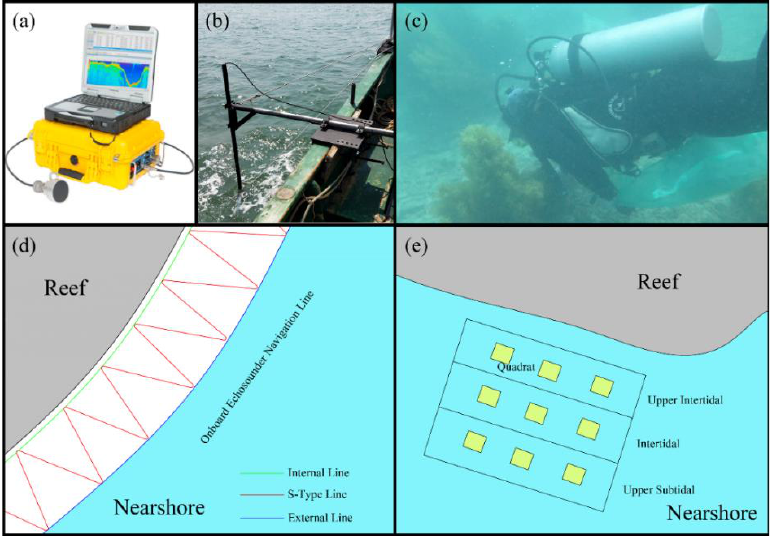
Figure 2. Equipment and methods. ( a ) BioSonics MX echo detector; ( b ) special support for detection; ( c ) scuba diving; ( d ) sonar scanning track line; ( e ) quadrat layout for seaweed sampling.